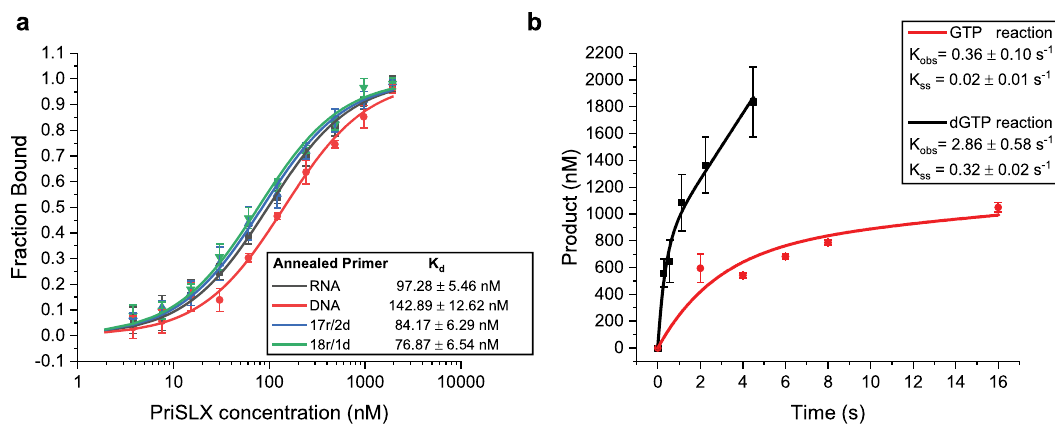
Fig. 5 Binding and kinetic analyses of PriSLX. a K d determination by fl uorescence polarization. Titration series of PriSLX as indicated with indicated 5 ′ - cy5-labeled primer annealed to 80 nt template. Data points indicate the mean and error bars represent standard deviation. Four independent replicates of this experiment were performed. b Steady-state kinetic analysis of PriSLX to determine initial rate of product formation (K obs ) and steady-state turnover rate (K ss ). Single nucleotide elongation reactions with GTP or dGTP as indicated and 5 ′ -cy5-labeled 19 nt RNA-primer annealed to 80 nt template. Reactions timed by rapid quench fl ow as indicated; 60 °C. Data points indicate the mean and error bars represent standard deviation. Two independent replicates of this experiment were